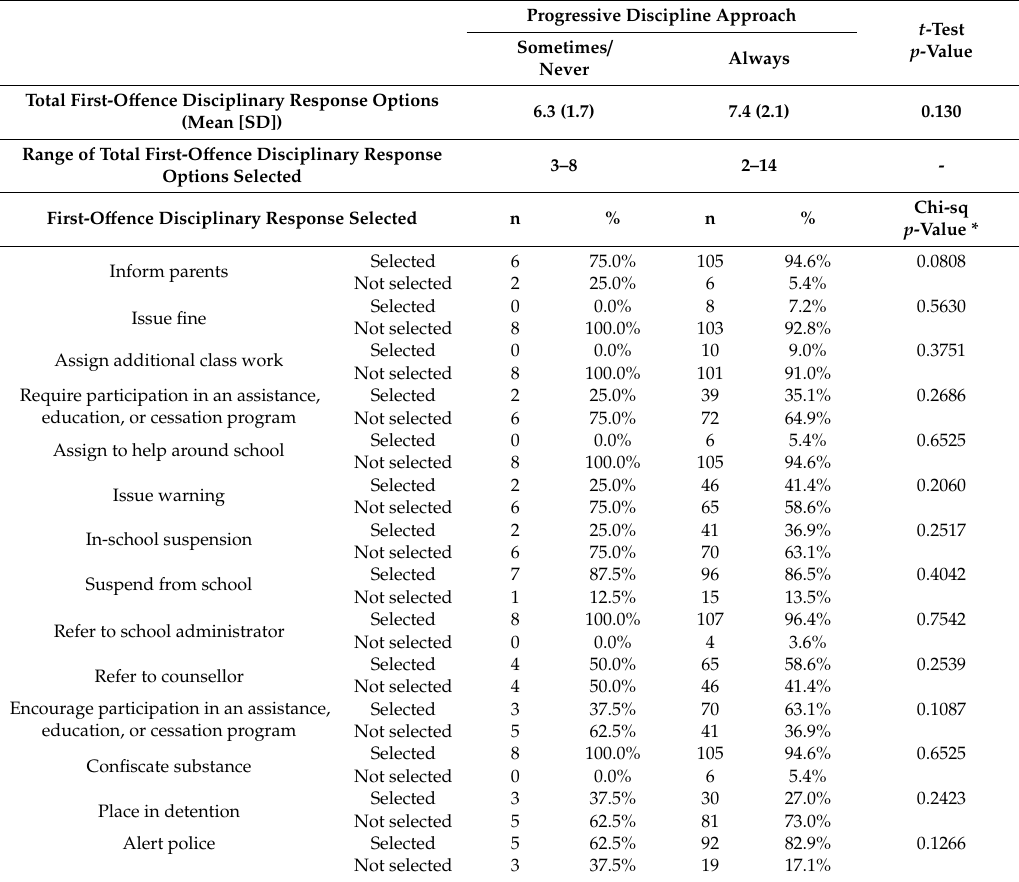
Table 4. Comparing secondary schools in Year 6 (2017 / 2018) of the COMPASS study based on use of a progressive discipline approach for student violations of school substance use